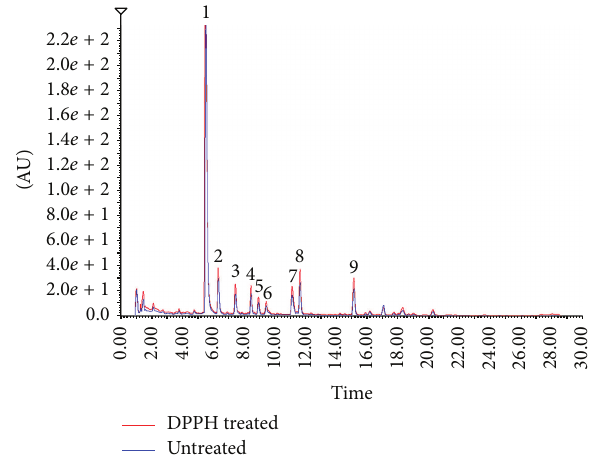
Figure 2: Chromatograms of the ethyl acetate fraction of Selaginella doederleinii before and after reaction with DPPH